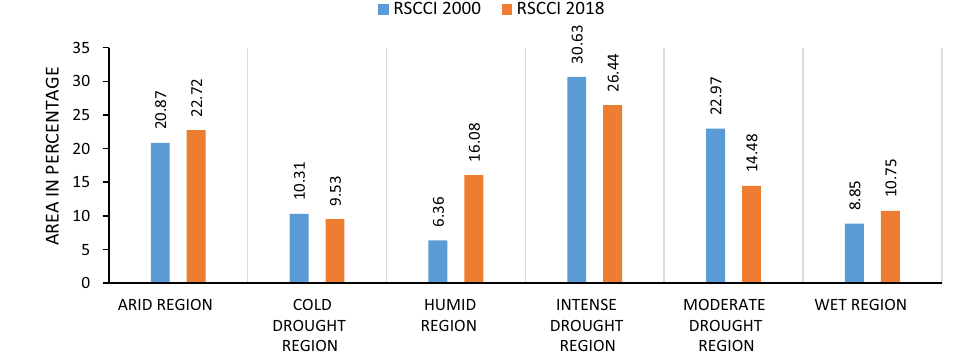
on the map, arid class with yellow color, humid regions with green color scheme, while wetlands with blue and cyan color on the map, and cold drought class is represent with purple color 20